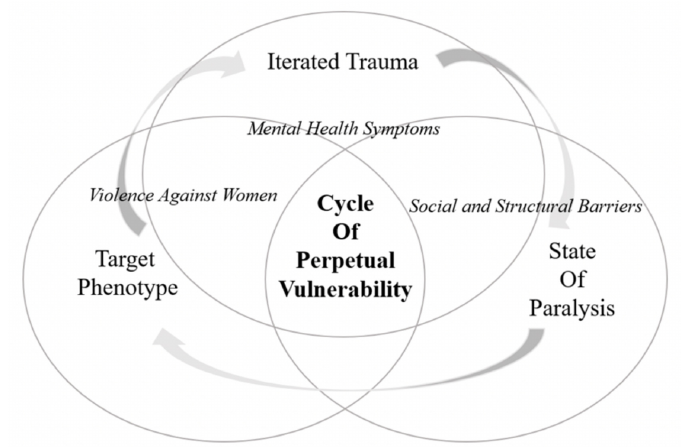
Figure 1. A theory of a Cycle of Perpetual Vulnerability.